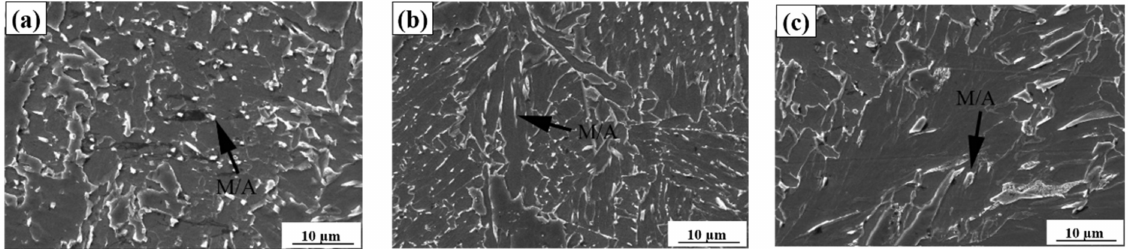
Figure 3. SEM images of the CGHAZ containing 0.14% Nb at varying heat inputs (kJ/cm). ( a ) 20, ( b ) 100, ( c ) 200.